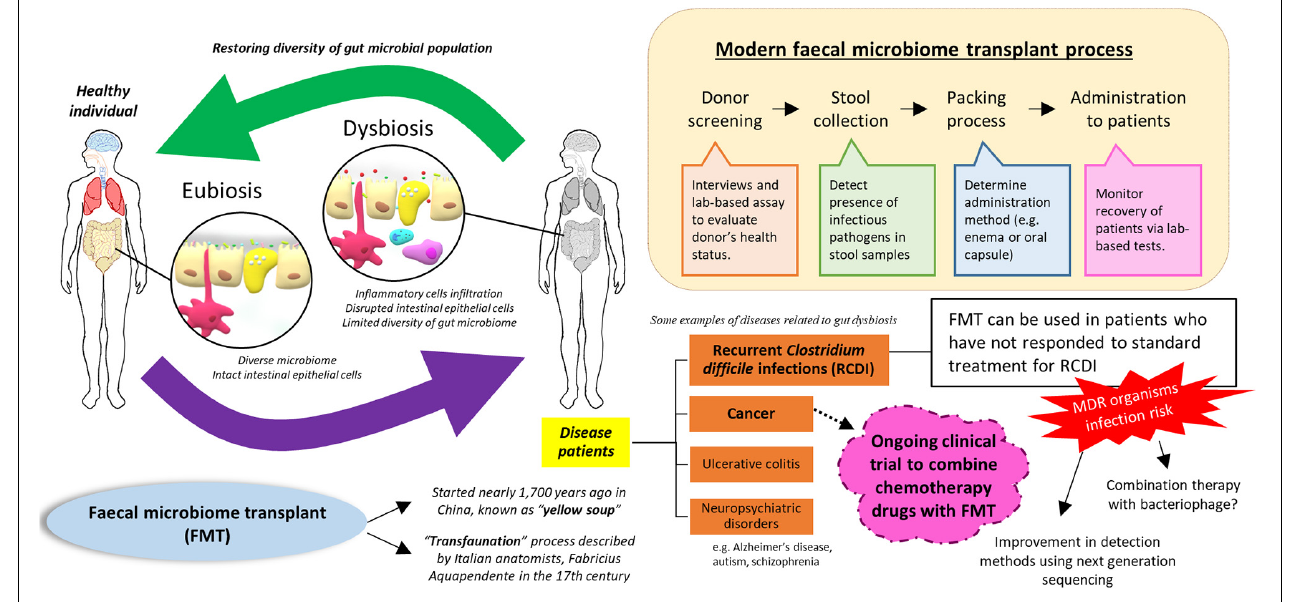
FIGURE 1 | Fecal microbiome transplant use to restore balance in the gut